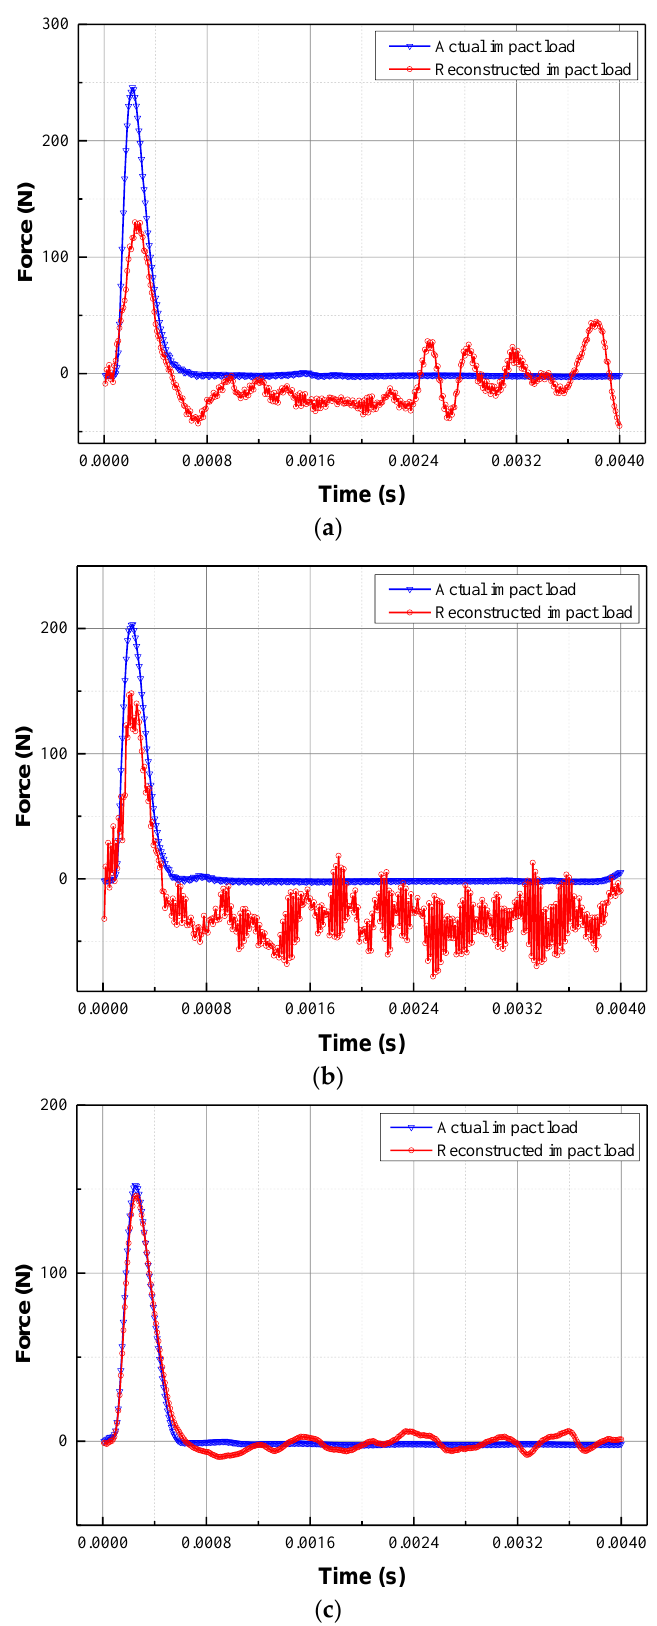
Figure 6. Reconstruction of the impact forces at ( a ) V4, ( b ) V20, and ( c ) V24 validation points.